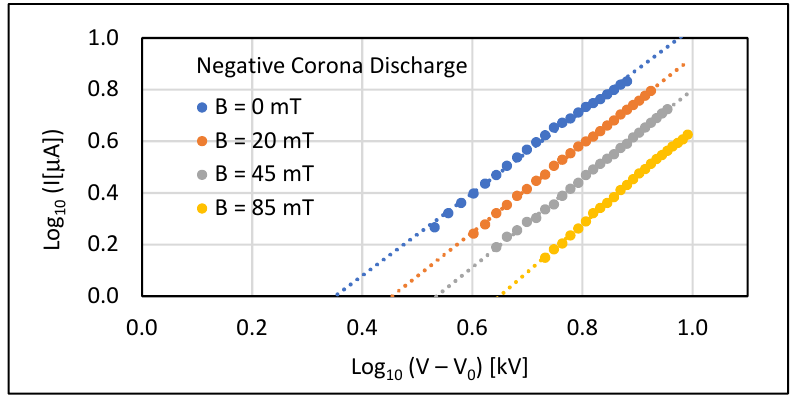
Figure 13. Corona current versus the voltage difference (V − V 0 ) on log 10 scale for positive corona discharge.